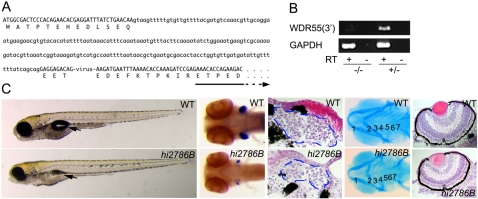
Zebrafish WDR55 mutant shows defect in thymus development.(A) Retroviral insertion in WDR55 locus of zebrafish hi2786B mutants. Uppercase letters indicate exons with predicted amino acids. Arrow indicates WDR domain. (B) Transcription of WDR55 3′ region and GAPDH in hi2786B (−/−) and heterozygous (+/−) zebrafish larvae at 6 dpf. cDNA was synthesized in the absence (−) or presence (+) of reverse transcriptase (RT). (C) Phenotypes of WT (top) and hi2786B (bottom) zebrafish. Far left panels show lateral views of 6-dpf larvae. Arrows indicate swim bladder. Second panels from the left show whole-mount in situ hybridization of 6-dpf larvae using rag1 probe. Ventral views are shown. Embryos were treated with H2O2 to bleach pigment cells. Middle panels show hematoxylin-eosin (HE) staining of transverse sections at 6 dpf. Broken blue lines indicate the thymus. Second panels from the right show Alcian blue staining of 6-dpf larvae. Ventral views are shown. Numbers indicate pharyngeal arches. Far right panels show HE staining of transverse sections of the eyes at 6 dpf.